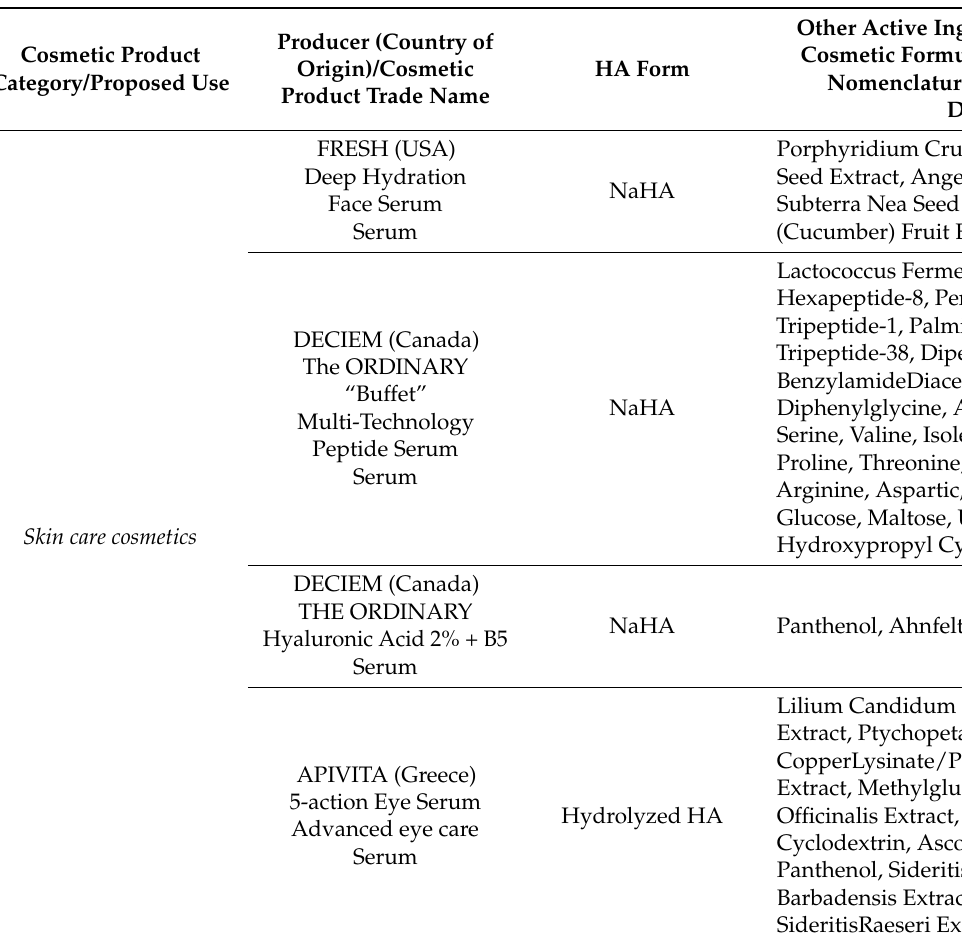
Table 1. Commercially available cosmetics incorporating HA and HA